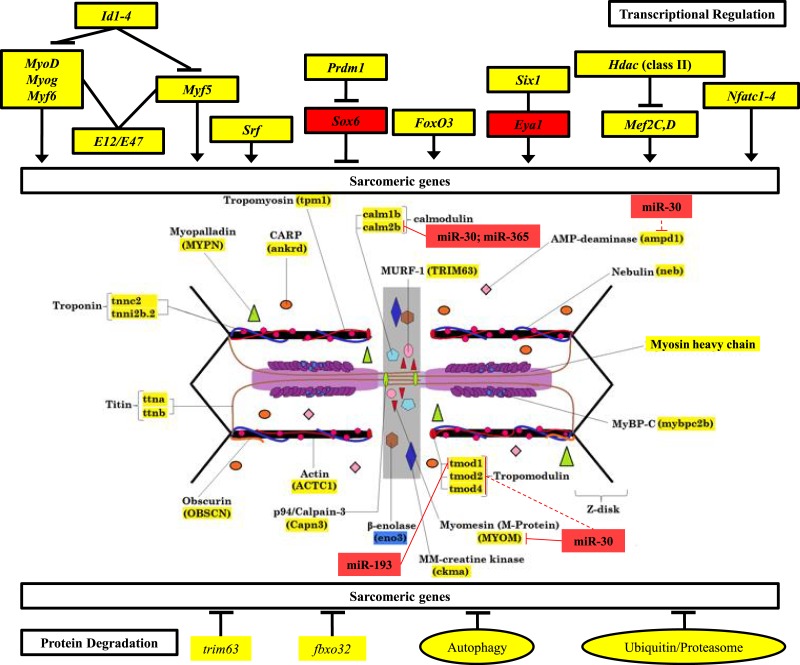
Mechanisms of control of sarcomeric gene expression in skeletal muscle and electric organ of S. macrurus.Our qRT-PCR and transcriptome analysis of the expression of sarcomeric genes in muscle and EO of S. macrurus demonstrates that all transcription factors associated with maintenance of sarcomeric gene expression are similarly expressed, or even upregulated in the EO of S. macrurus relative to muscle (Top). Concomitantly, virtually all sarcomeric genes are transcribed at similar levels in both EO and muscle (middle), suggesting that transcriptional regulation is not the main driver of the loss of sarcomeres in EO. Additionally, genes associated with protein degradation are similarly expressed in EO and muscle (bottom), suggesting that protein degradation should not differ between both tissues. Finally, we identified a set of upregulated miRNAs and predicted a set of targets within the sarcomere (middle) that provide evidence of an important role of post-transcriptional regulation in controlling the partial muscle phenotype observed in the EO of S. macrurus. Names highlighted in red represent transcripts that were >4-fold upregulated in EO relative to muscle; Names highlighted in yellow represent transcripts that are similarly expressed in EO and muscle; Names highlighted in blue represent transcripts that were >4-fold upregulated in muscle relative to EO. miRNA target predictions with dashed lines represent targets predicted in D. rerio only using TargetScan Fish v. 6.2 (Lewis, Burge & Bartel, 2005; Ulitsky et al., 2012); miRNA target predictions with solid lines represent conserved targets in both D. rerio and S. macrurus as predicted by TargetScan Fish v. 6.2 (Lewis, Burge & Bartel, 2005; Ulitsky et al., 2012) and RNAhybrid (Rehmsmeier et al., 2004; Krüger & Rehmsmeier, 2006).